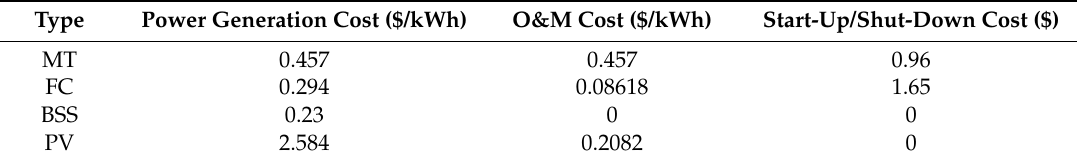
Table 4. Operation costs of DER units.